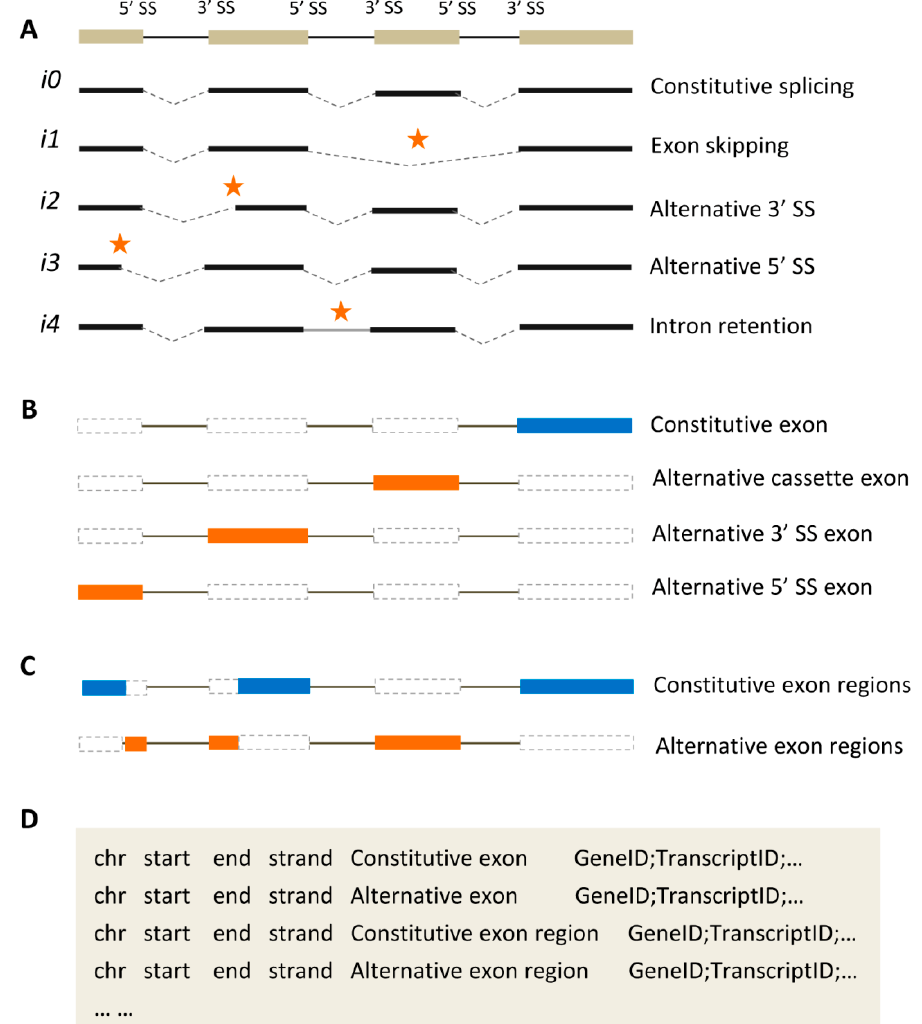
Figure 1. Schematic illustration of alternative splicing events and exon classification. Four representative types of alternative splicing events are demonstrated with a four-exon gene, in which each change is marked by an asterisk ( A ). The two kinds of exon classification are shown in ( B ) and ( C ), which could be accordingly annotated into a Browser Extensible Data (BED)-like file ( D ). Exons and introns are denoted by the colored boxes and solid lines, respectively. SS—splice site.